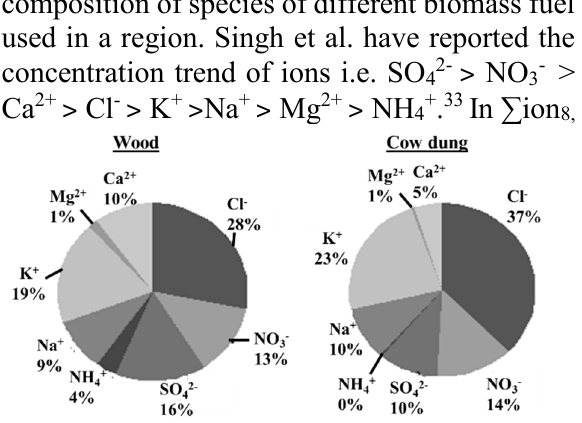
Fig.3 Percentage contribution of ions to the ∑ion 8 during burning of materials i.e. wood and cow dung.